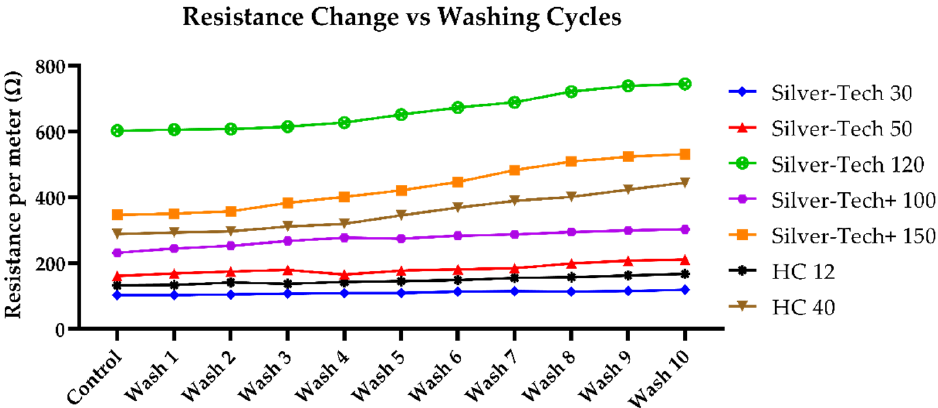
Figure 9. Change in average resistance-per-meter value after washing across all tested thread samples without protective polyamide thread on top.